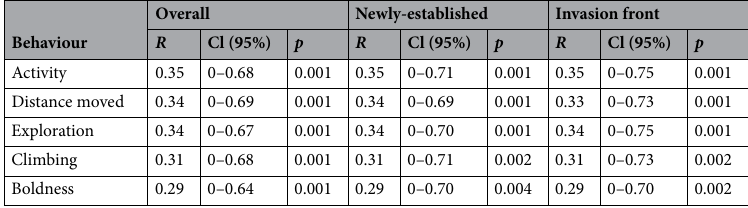
Table 3. Repeatability of behaviours in signal crayfish, measured over time.